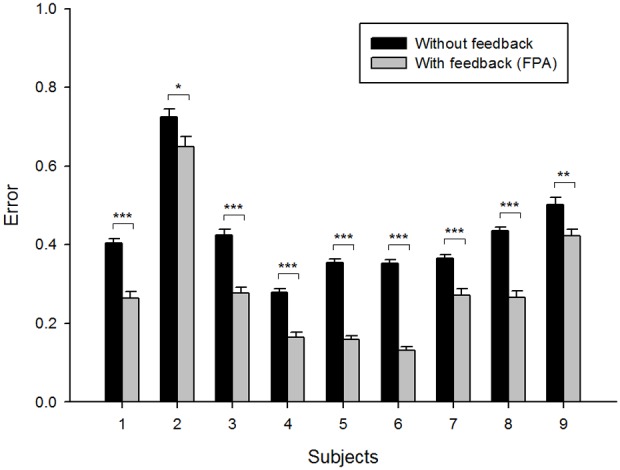
Error bar with standard error for each subject.Black bars illustrate errors in a case without feedback and gray bars represent errors in a case with feedback (FPA). *P = 0.021, **P = 0.002, ***P<0.001.